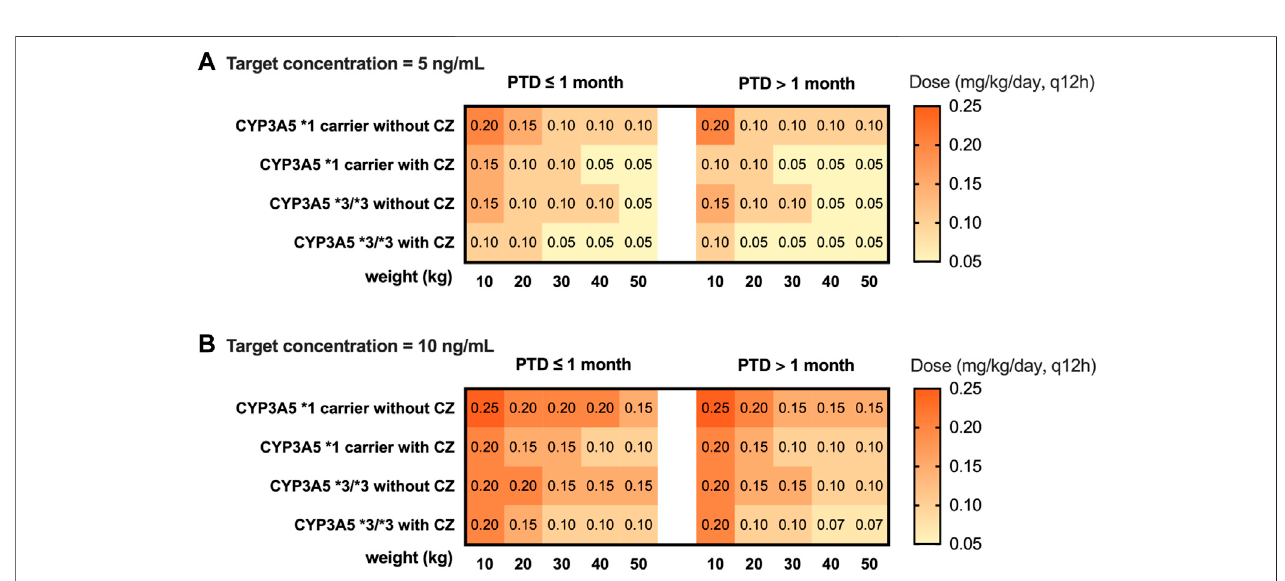
FIGURE 5 | Recommended oral dosage of tacrolimus for HSCT children (PTD ≤ 1 month, PTD > 1 month) based on target trough concentration 5 ng/mL (A) and 10 ng/mL (B) . The simulated HSCT children are CYP3A5*1 and CYP3A5*3/*3 carriers with a weight of 10 to 50 kg.